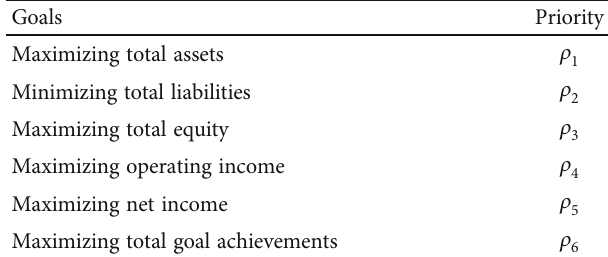
Table 1: Goals of bank with